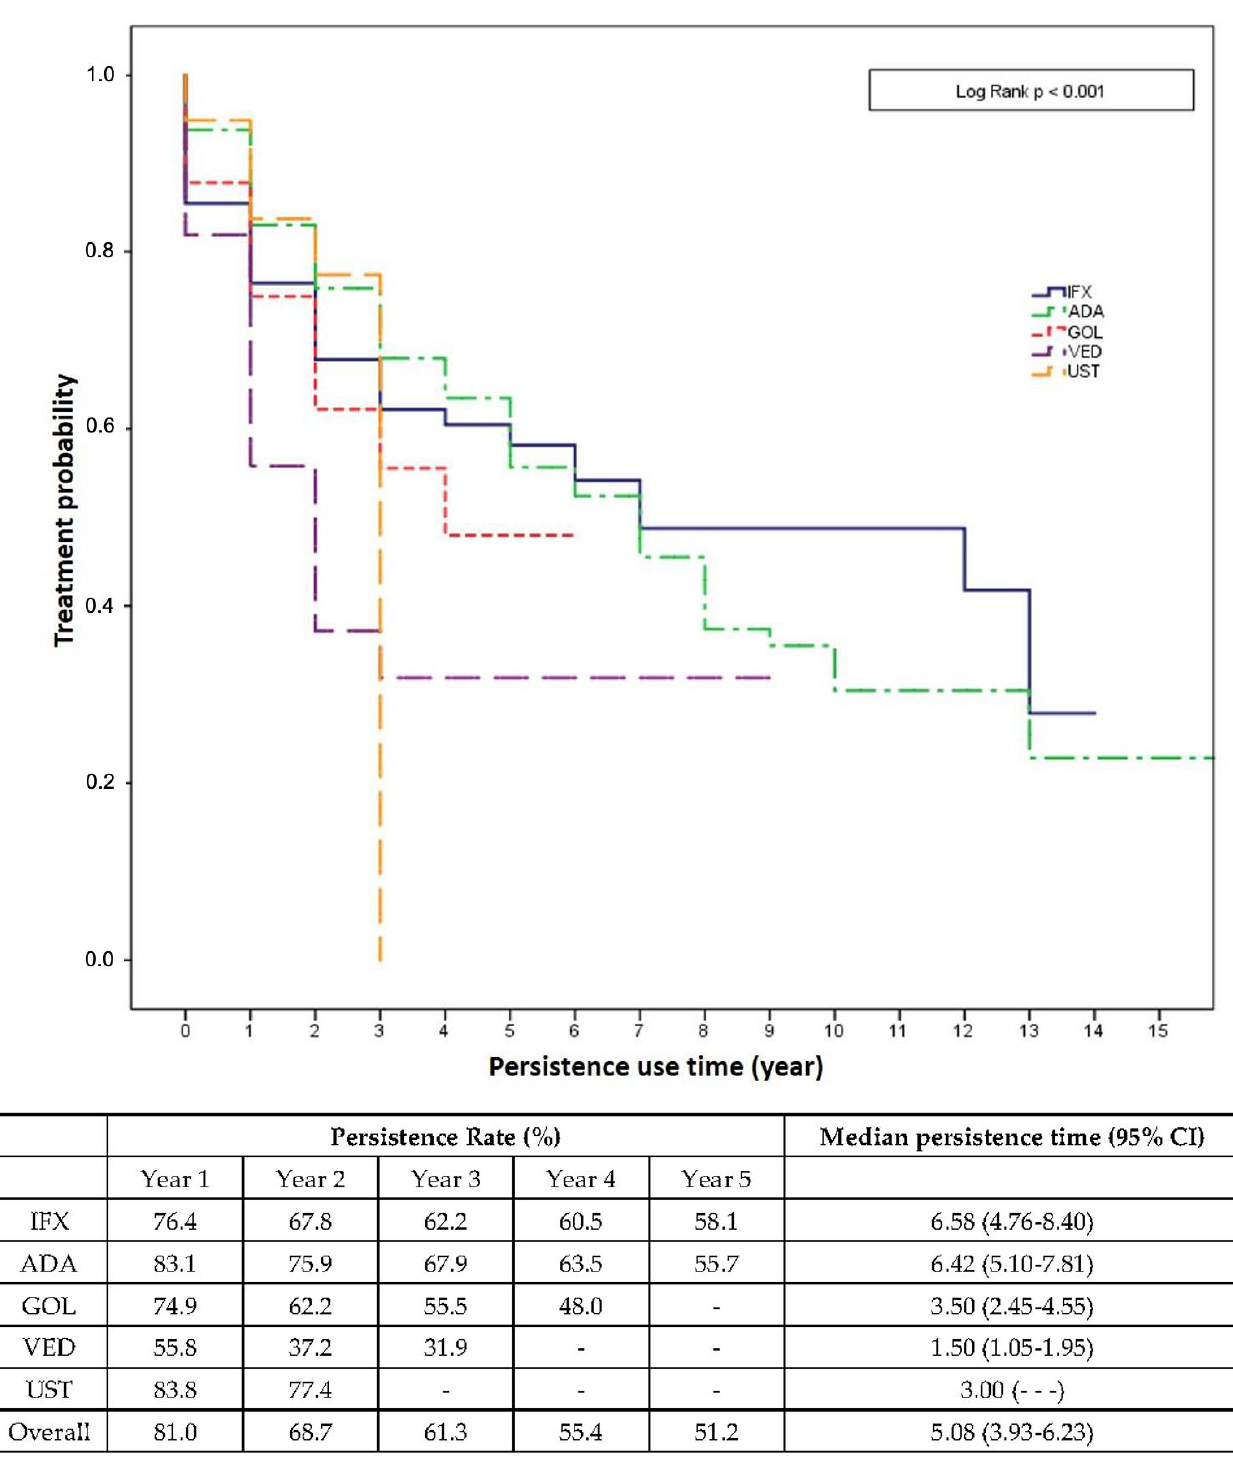
Figure 1. Kaplan – Meier curve for the persistence of biologics in patients with IBD. Abbreviations: ADA = adalimumab; CI = confi- Figure 1. Kaplan–Meier curve for the persistence of biologics in patients with IBD. Abbrevi- dence interval; GOL = golimumab; IFX = infliximab; VED = vedolizumab; UST = ustekinumab. ations: ADA = adalimumab; CI = confidence interval; GOL = golimumab; IFX = infliximab; VED = vedolizumab; UST =